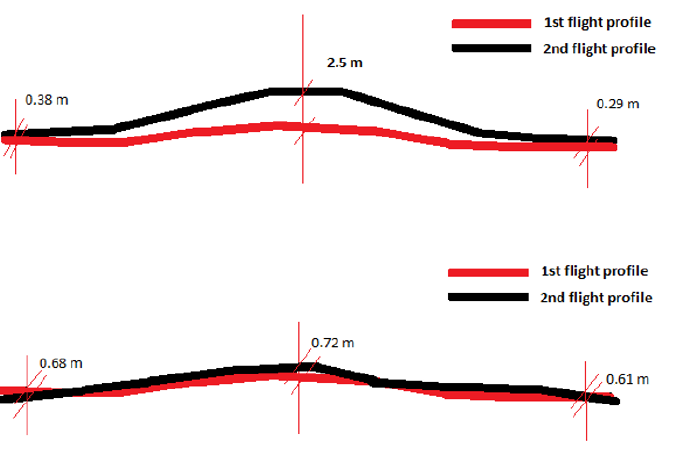
Figure 12. Schematic deformation of both models after joining the point clouds with control points, found at the edge of the model in a stone moraine (it should be stable). By joining both point clouds, the second was deformed in the middle due to the recalculation of the bundle adjustment (e.g., the internal and external parameters can be changed). For this reason, we used both point clouds, as they were processed separately, and the joining was made using similarity transformation only in external software.